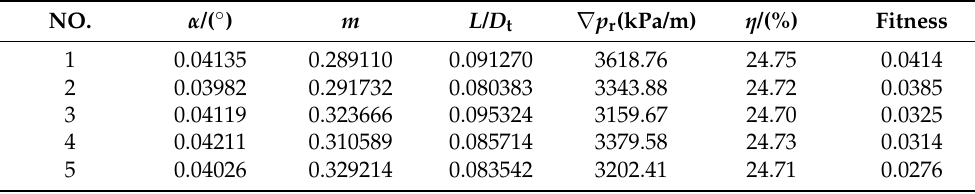
Table 4. Specific information of optimized Pareto solution ( ∇ p r - η ).